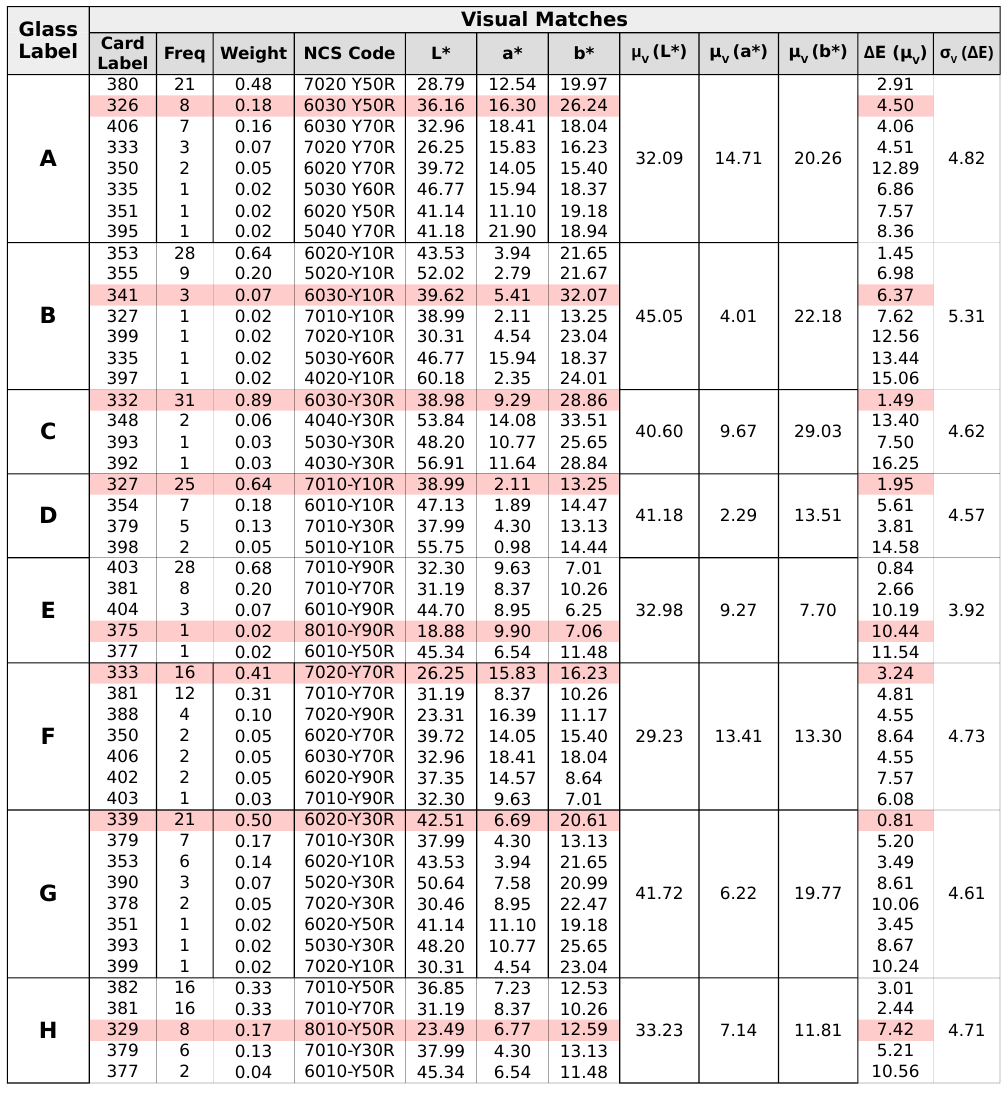
Table A4. Results from our visual matching experiment for the red-brown colour group. A visual average colour µ v was obtained from the matched NCS exterior set samples, weighted by their frequency. The weighted population standard deviation σ v was then derived based on each samples’ colour difference ∆ E to µ v . The computationally matched NCS exterior set samples are highlighted in